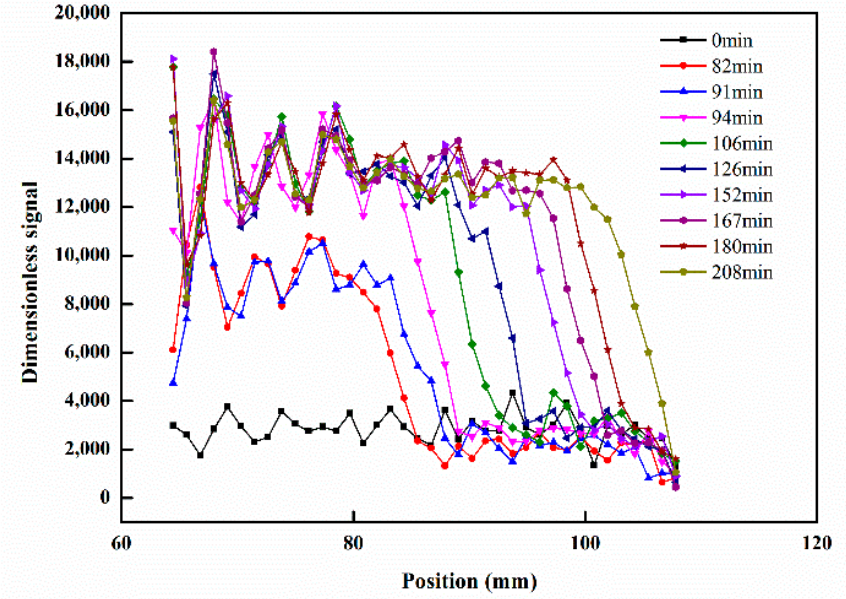
Figure 7. One-dimensional frequency coding of the fracturing fluid imbibition process of core 57.